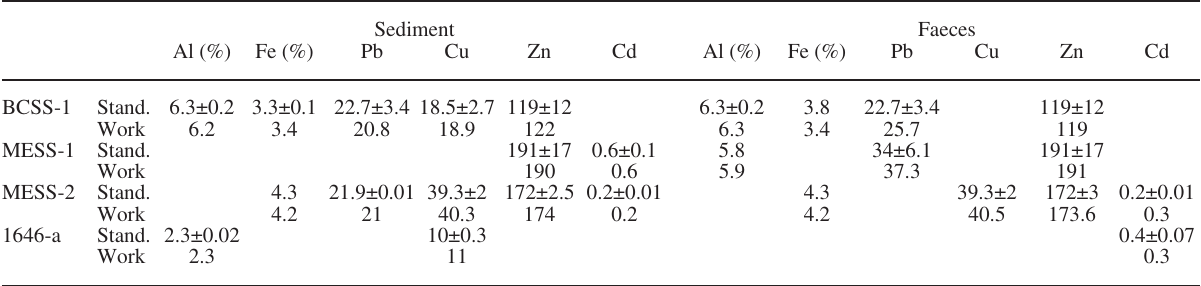
Table 2. – C ertified concentrations of Fe, Zn, cu, Pb and cd (µg g -1 d.w.) averaged over standard reference materials (DorM-1, DorM-2, nBs) and standard deviation (±sd) for sediments and faeces; d.w., dry weight; stand.,